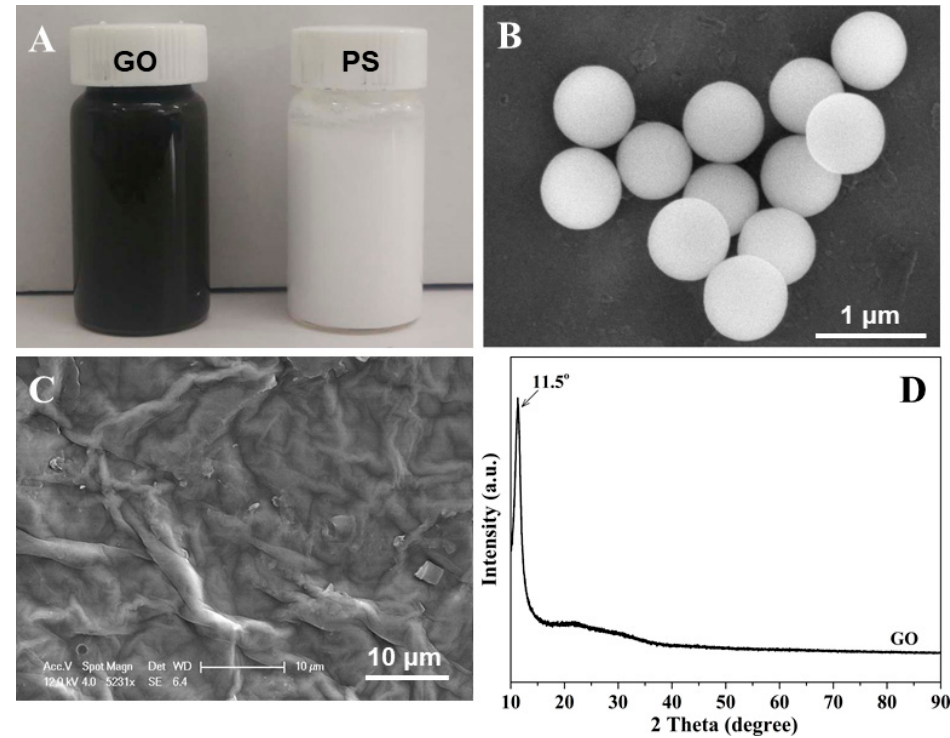
Figure 1. ( A ) Digital photo of GO and PS solutions, SEM images of ( B ) PS colloidal particles and ( C ) GO film, and ( D ) XRD pattern of GO.